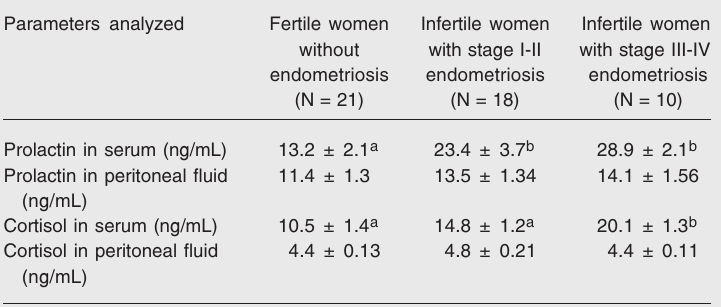
Table 3. Prolactin and cortisol concentrations in serum and peritoneal fluid of